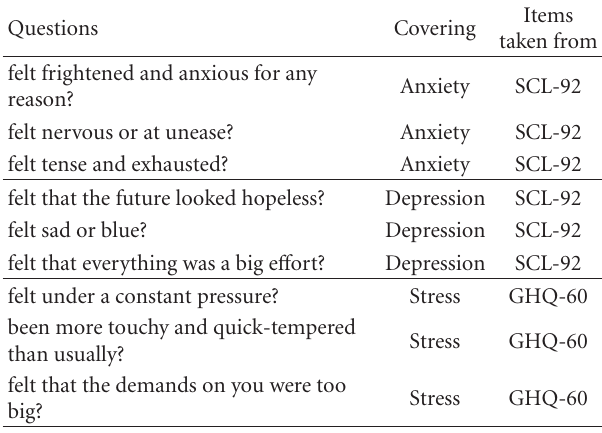
Table 1: Questions about anxiety, depression, and stress during pregnancy ∗ . “Have you ...